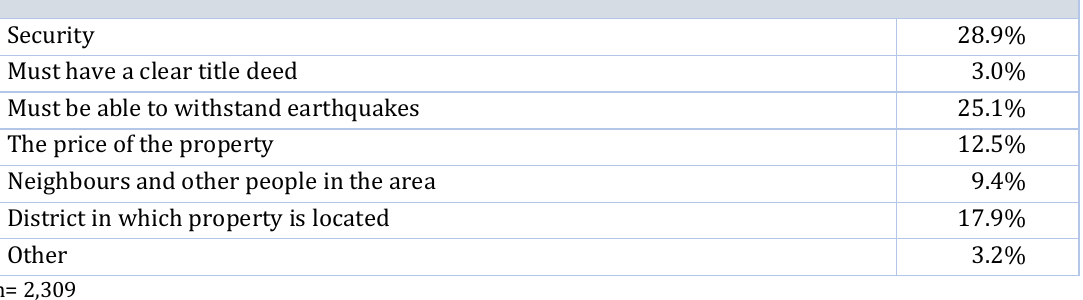
Table 4: Priorities in choosing a property